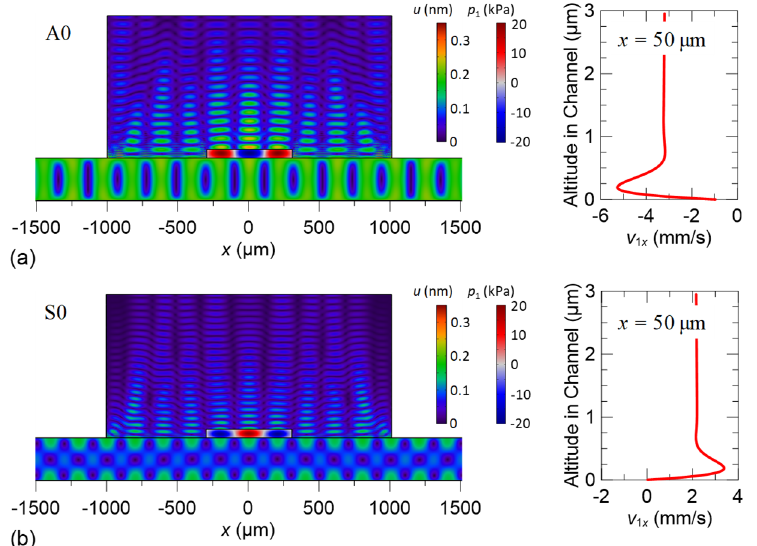
Figure 6. Simulated elastic–acoustic coupled fields on the full cross-section of the device and tan- gential velocity component v 1 x of the acoustic fields at x = 50 µ m near the channel bottom excited at ( a ) the A0-mode frequency and ( b ) the S0-mode frequency.